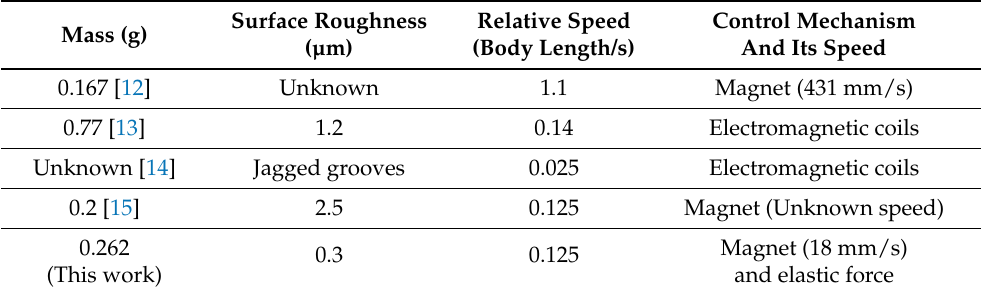
Table 1. Performance comparison of existing magnetic inchworm robots and the proposed one. Surface Roughness Relative Speed Control Mechanism Mass (g) (µm) (Body Length/s)